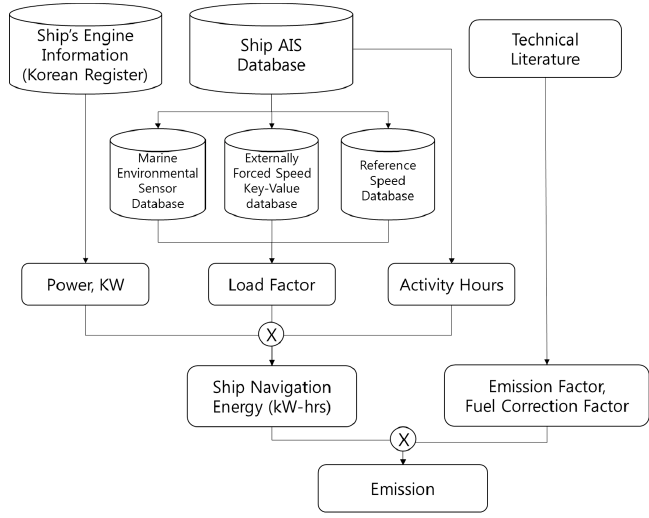
Figure 3. Information sources and emission quantity estimation.